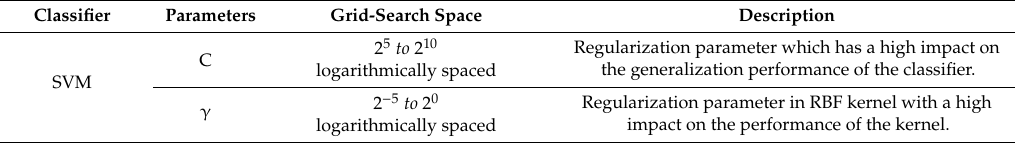
Table 4. The definition of grid search space for tuning the hyper-parameters support vector machine